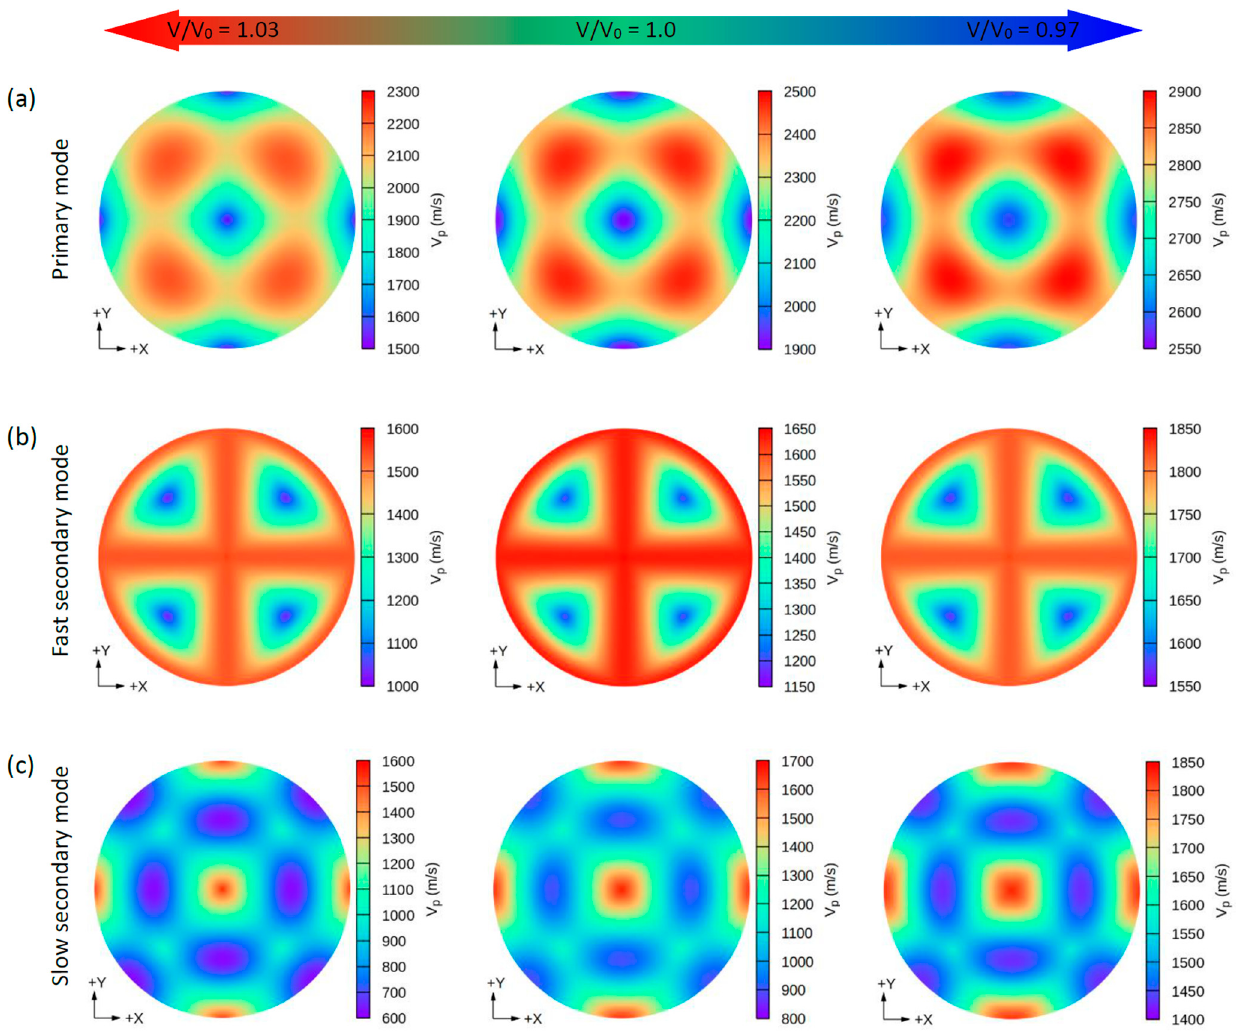
Figure 5. The calculated 2D directional dependence of the phase wave velocity (V p ) in (xy)/(001)-plane for CsK 2 Bi. There are two types of acoustic wave velocities, i.e., the longitudinal wave velocity and the transverse wave velocities in two directions. The single primary mode ( a ) is the longitudinal wave velocity and the two secondary modes, namely, fast secondary ( b ) and slow secondary ( c ), correspond to the transverse wave velocities.